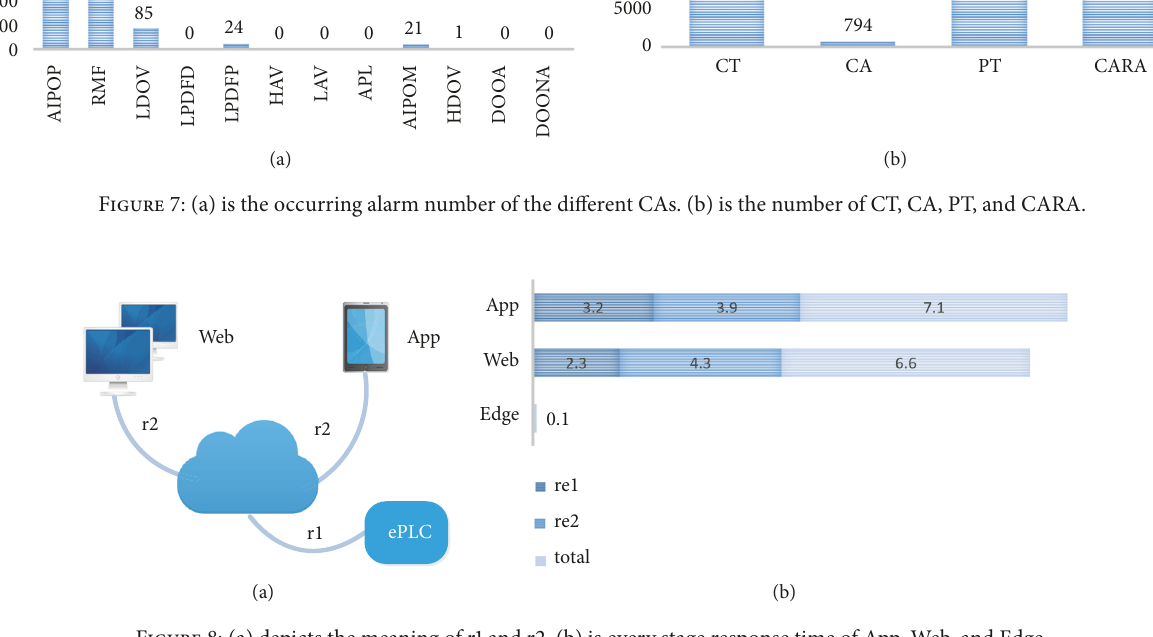
Figure 8: (a) depicts the meaning of r1 and r2. (b) is every stage response time of App, Web, and Edge.